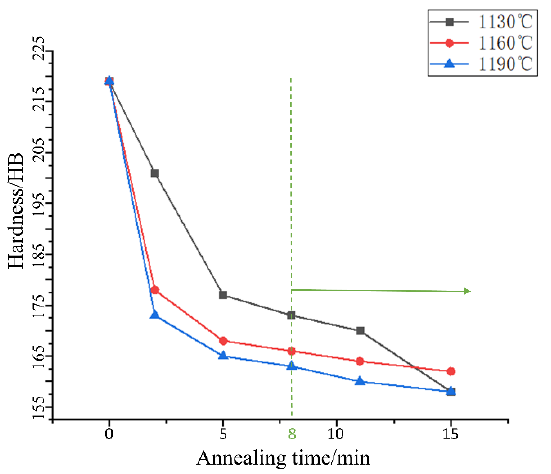
Figure 1. Effect of annealing temperature and time on the hardness of 45# steel.